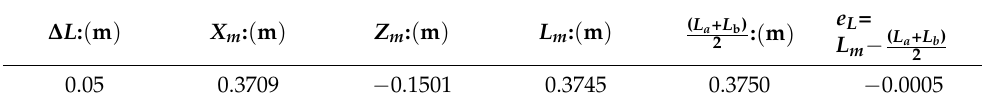
Table 6. The length of assumed backbone in difference ∆ L (data from experiment, L b =0.35